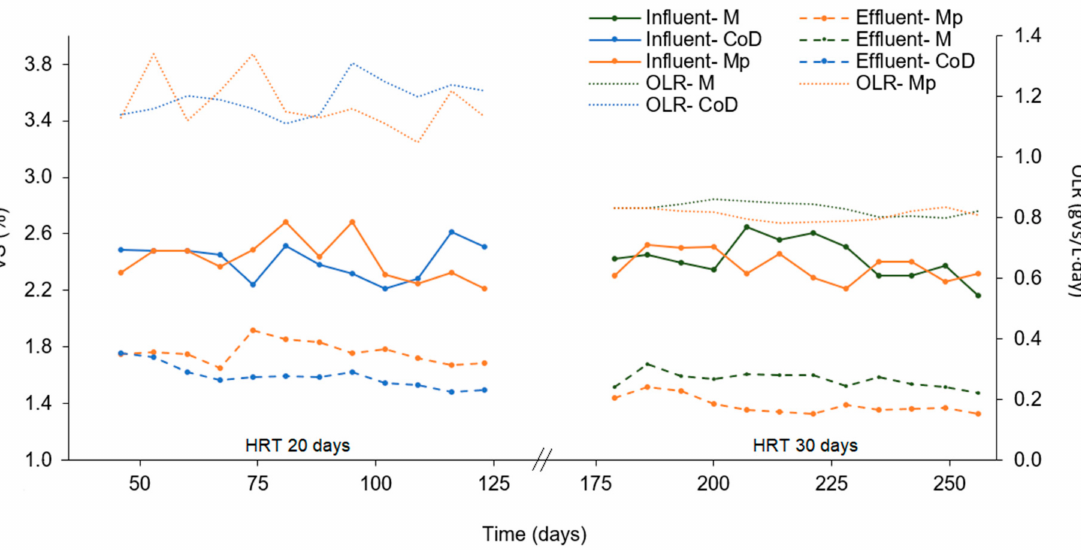
Figure 2. Influent and effluent volatile solids of untreated microalgae (M), thermally pretreated microalgae (Mp) and in co-digestion with primary sludge (CoD) for the studied periods: Period I at a HRT of 20 days and Period II at a HRT of 30